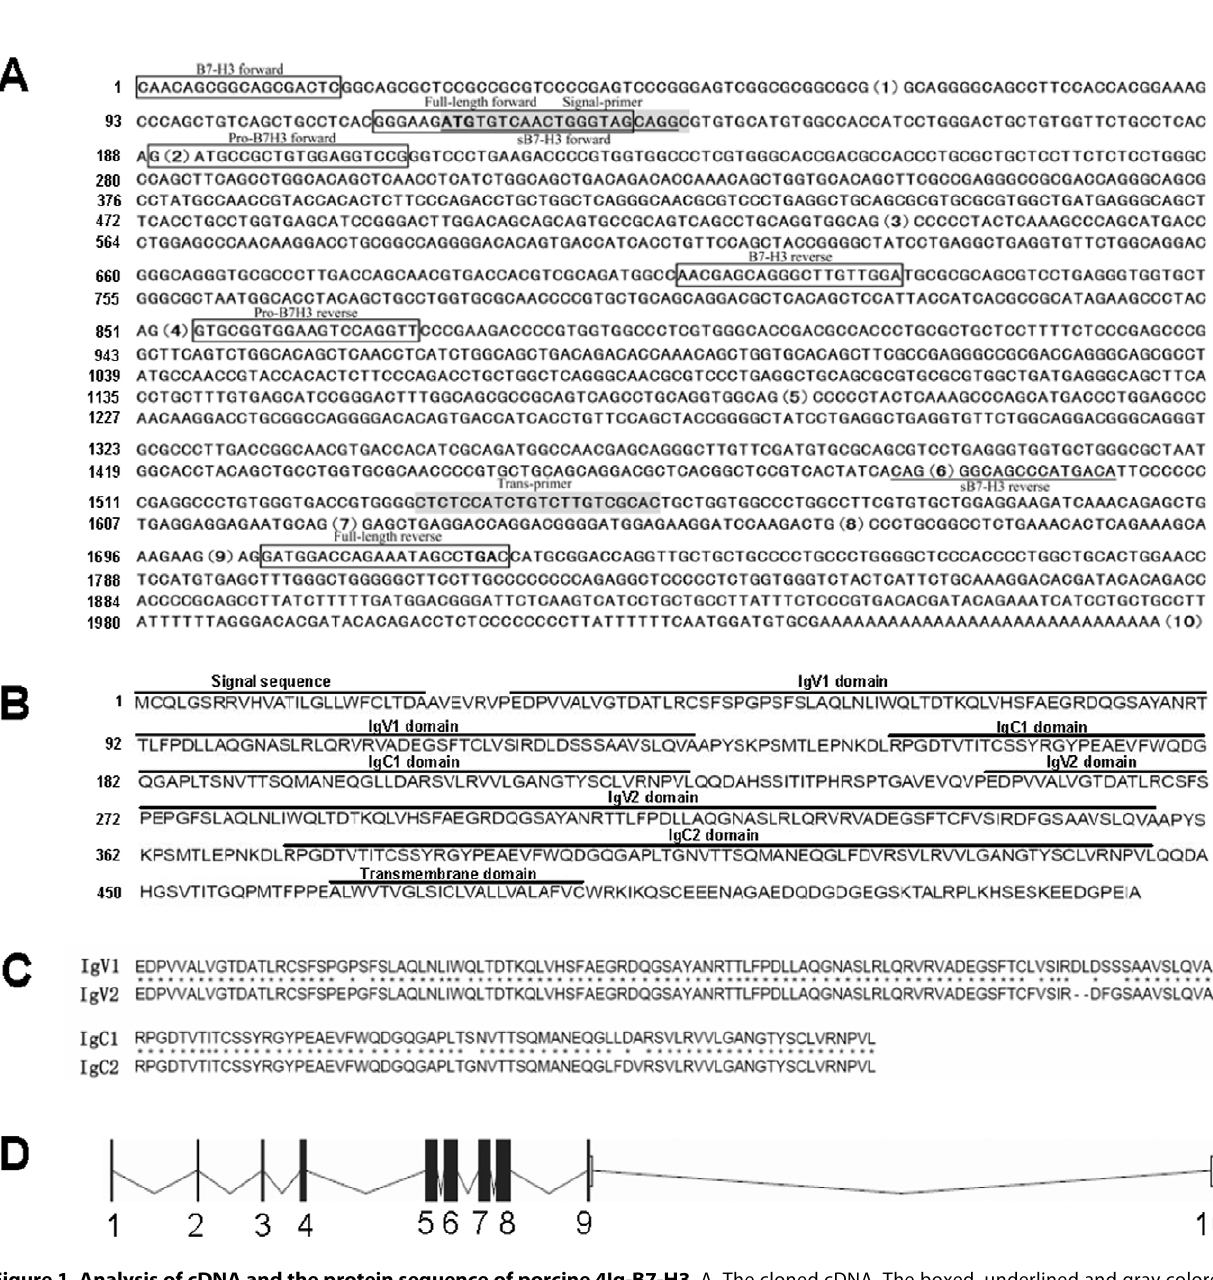
Figure 1. Analysis of cDNA and the protein sequence of porcine 4Ig-B7-H3. A, The cloned cDNA. The boxed, underlined and gray colored sequences show the positions of all used primers. The numbers in the brackets are the exon order of porcine B7-H3 in the genome. The strong ATG and TGA are initiation and stop codons. All exons contain the complete sequence in the genome but exon 1 in the cDNA. The numbers on the left are the base count of cDNA. B, The predicted protein sequence. The numbers on the left are the count of amino acids . All predicted domains are marked above the sequence. C, Alignment of the duplicated amino acid sequences of the two IgV and IgC-like domains, respectively. Asterisks indicate the identical amino acids. D, Schematic structure of CD276 nucleotide sequence in the porcine genome. The filled panes and lines represent Exons and Introns, respectively. The numbers under the schematics is the order of the Exons in the genome.